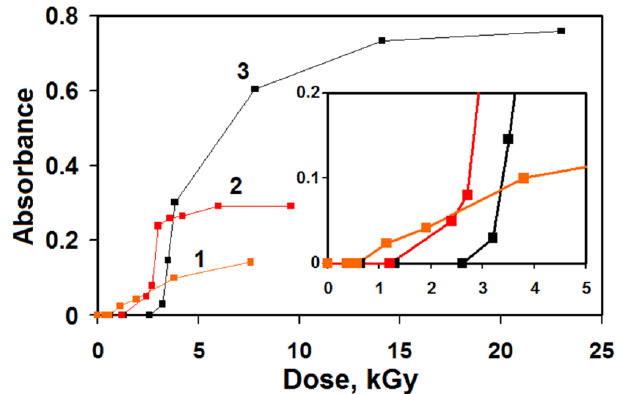
Figure 7. The dose-dependences of the optical density of the LSPR bands of AuNPs of the irradiated VT – Au(III) solutions with various ratios of VT to Au(III): 160/1 (1), 80/1 (2), 40/1 (3).